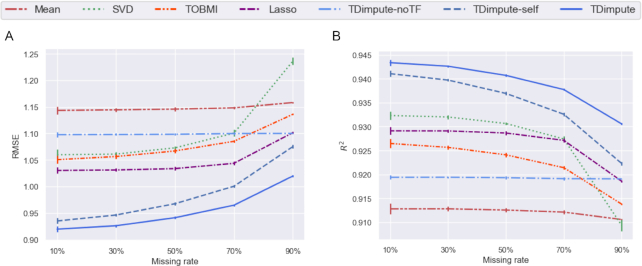
Imputation accuracy of each imputation method. Results were averaged across 16 imputed cancer datasets. (A) RMSE values of each method. (B) The squared Pearson correlation coefficient (\documentclass[12pt]{minimal}
\usepackage{amsmath}
\usepackage{wasysym}
\usepackage{amsfonts}
\usepackage{amssymb}
\usepackage{amsbsy}
\usepackage{upgreek}
\usepackage{mathrsfs}
\setlength{\oddsidemargin}{-69pt}
\begin{document}
}{}${{\boldsymbol{R}}^2}$\end{document}) between each sample of the imputed data and the original full data. TDimpute-self indicates TDimpute trained and predicted on the target cancer dataset. TDimpute-noTF indicates TDimpute trained on the pan-cancer dataset (excluding the target cancer) and predicted on the target cancer dataset. The error bar shows the standard deviation.